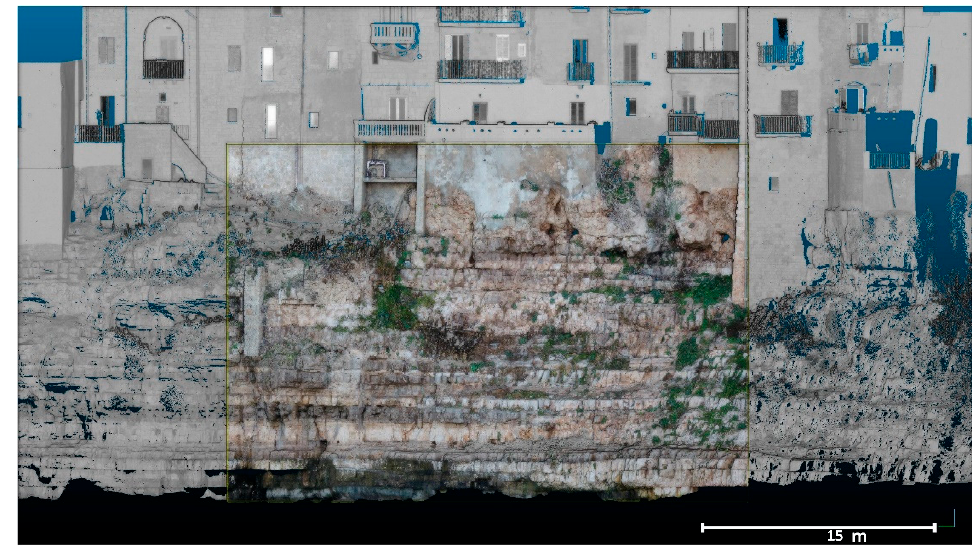
Figure 4. Final high-resolution point cloud (RGB colors) of the study site obtained by means of UAV technique and aligned on a georeferenced TLS point cloud (in gray) to avoid doming deformations. The UAV point cloud has a surface density of 13391 points/m 2 , corresponding to a mean point spacing of 9 mm.